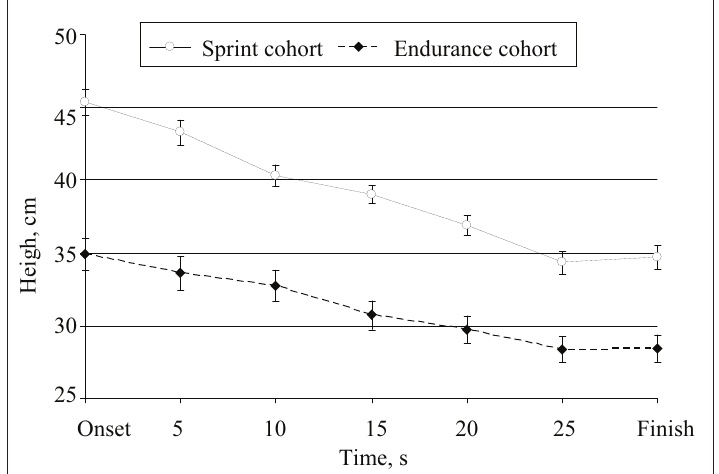
Figure 1. Dynamics of jumps height while performing 30‑s jump